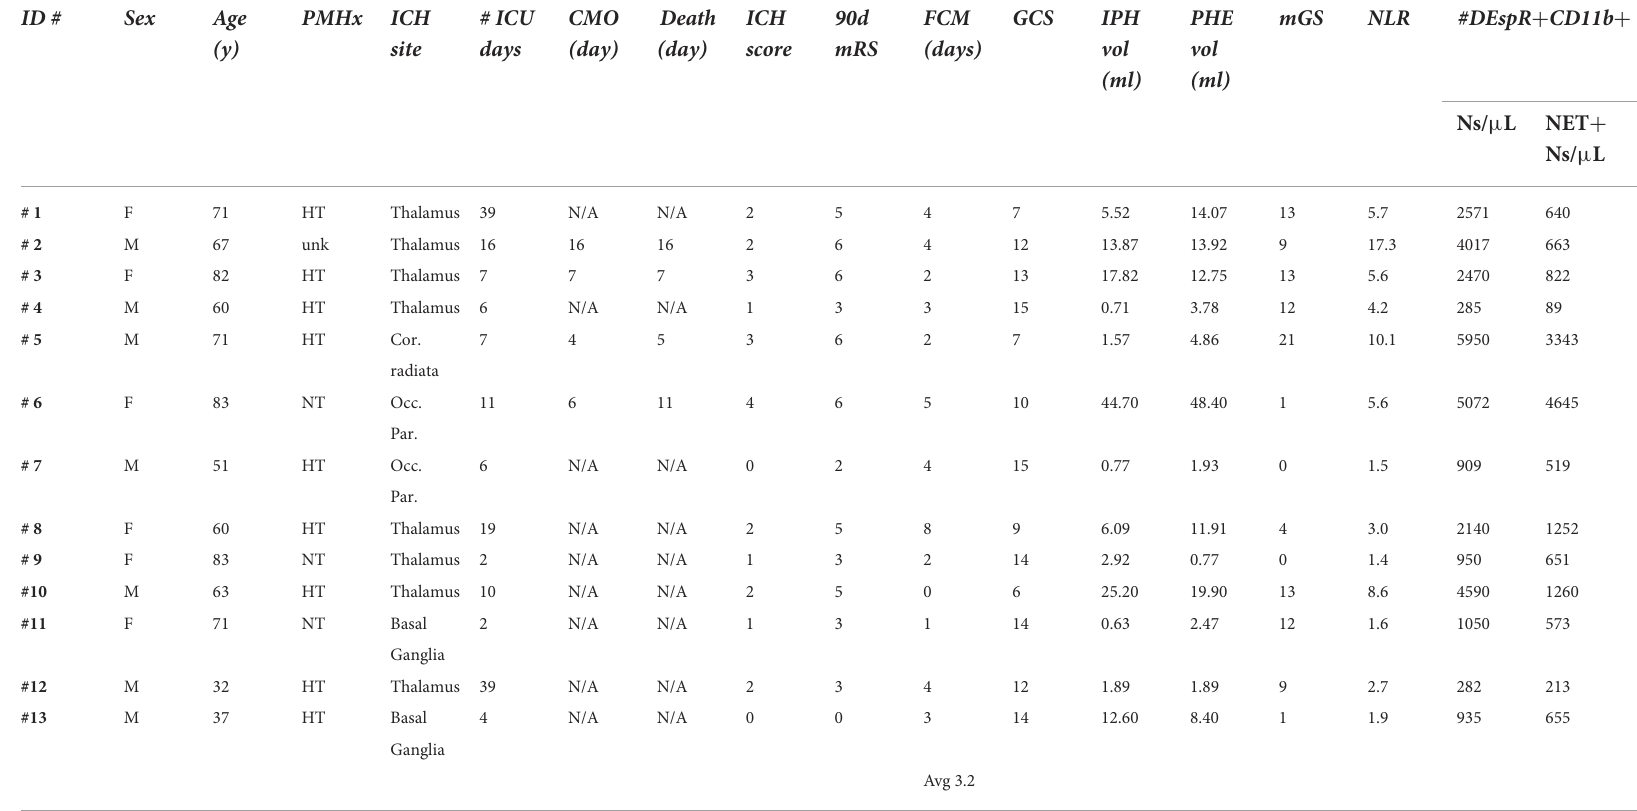
TABLE 1 Summary of key patient